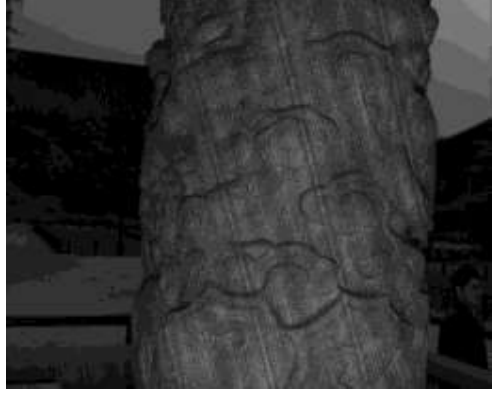
Figure 2. Image with coded light captured by F5